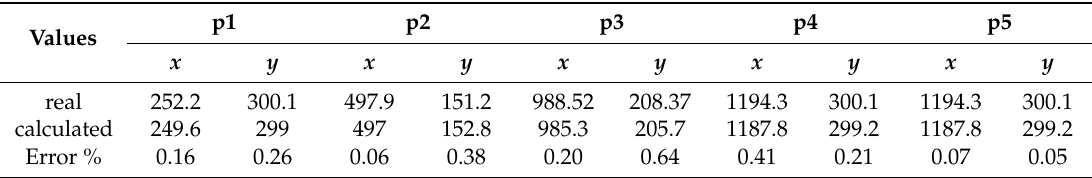
Table 3. Results table of the target points